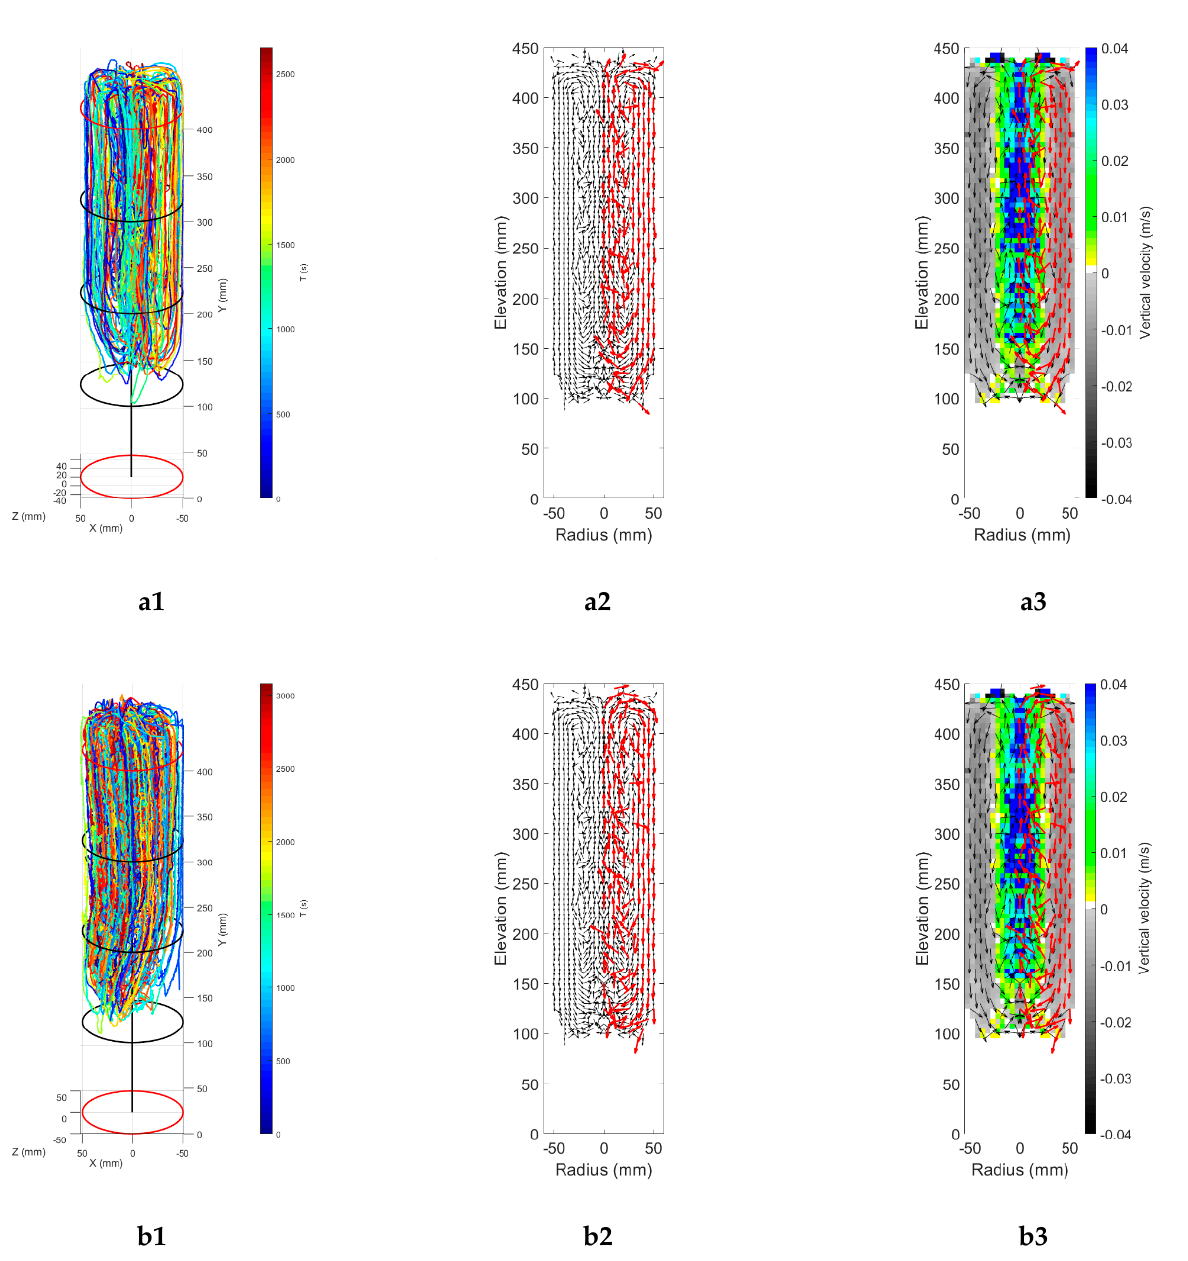
Figure 8. The results of 2 runs ( a , b ) of the − 150 + 106 µm hematite particle for an airflow rate of 1.50 u mf (Lagrangian trajectory (1) and Eulerian flow maps (2 and 3)).